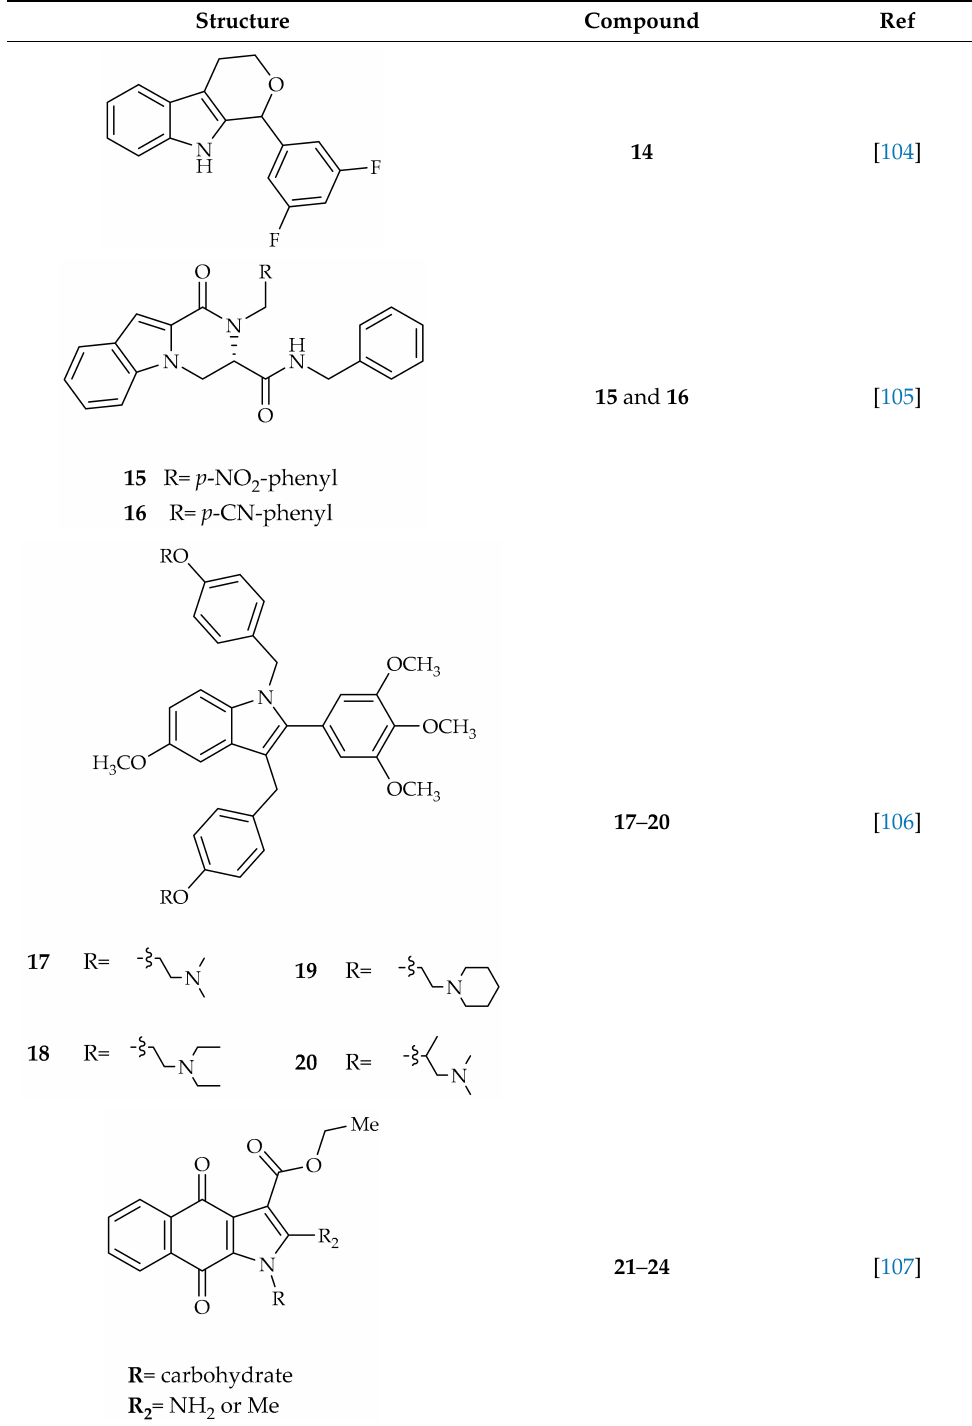
Table 3. Structure of indole derivatives studied for the treatment of